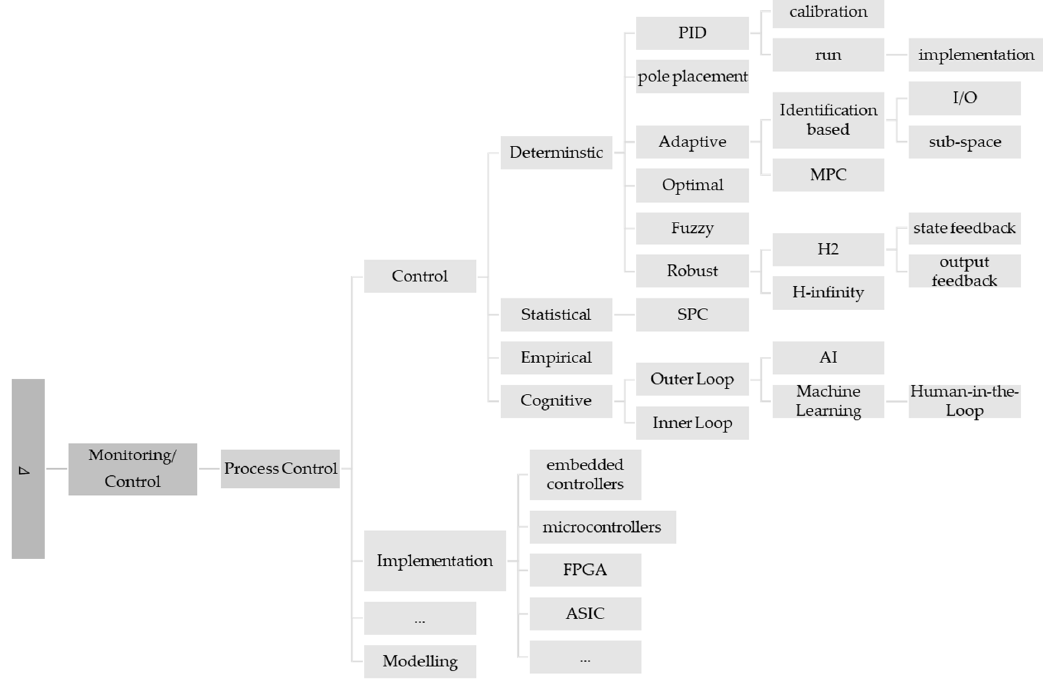
Figure A5. Technologies’ classification detail on process control.